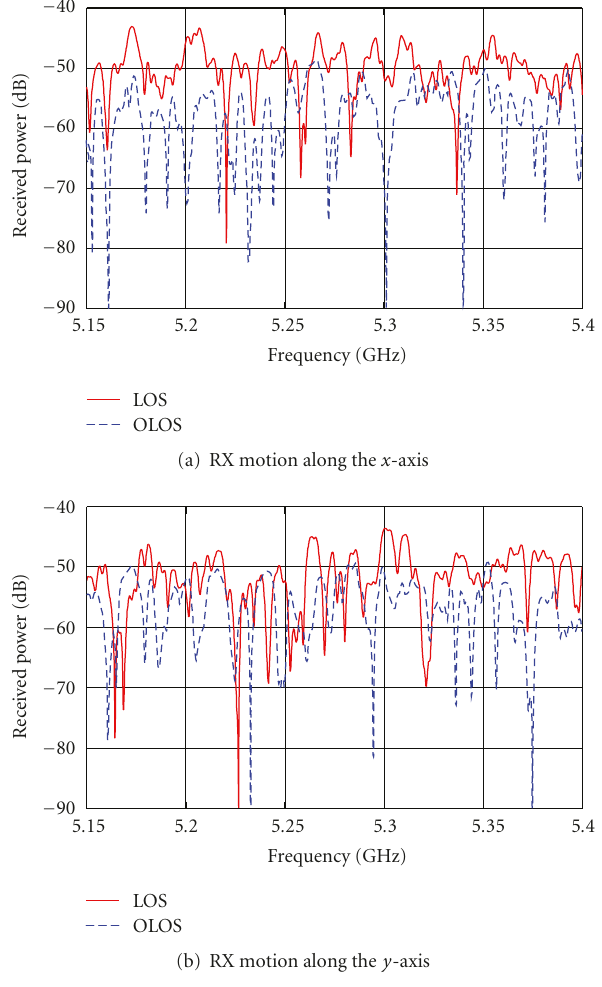
Figure 7: Received power of SISO channel in the frequency domain at the first spatial measurement position.